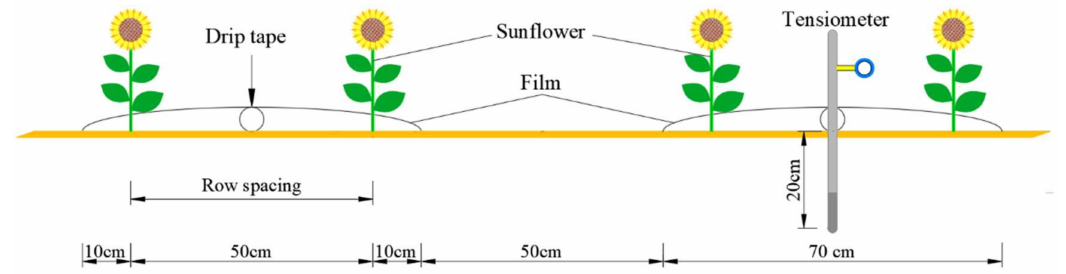
Figure 4. The experimental schematic diagram for the sunflower